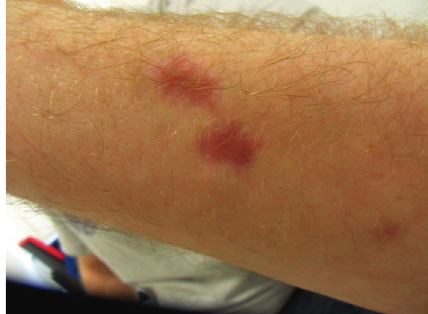
Figure 2: Residuum of skin necrosis, lower thigh, May